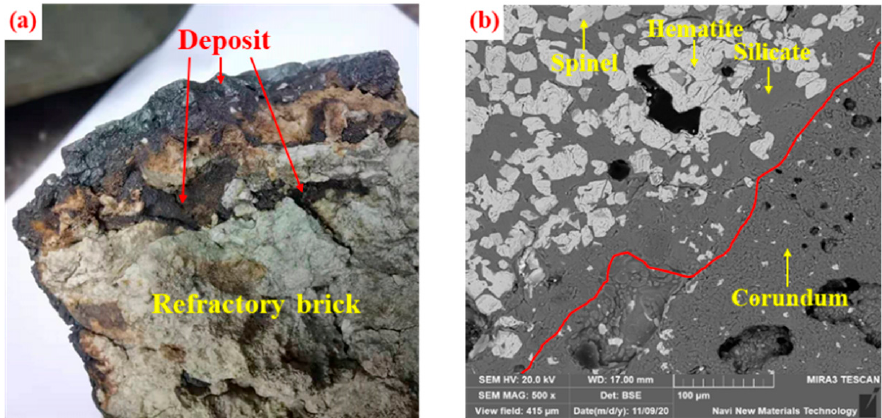
Figure 6. The morphology of ring adhesion to firebrick, including ( a ) the macroscopic morphology of ring adhesion to firebrick; ( b ) the micromorphology of ring adhesion to firebrick.